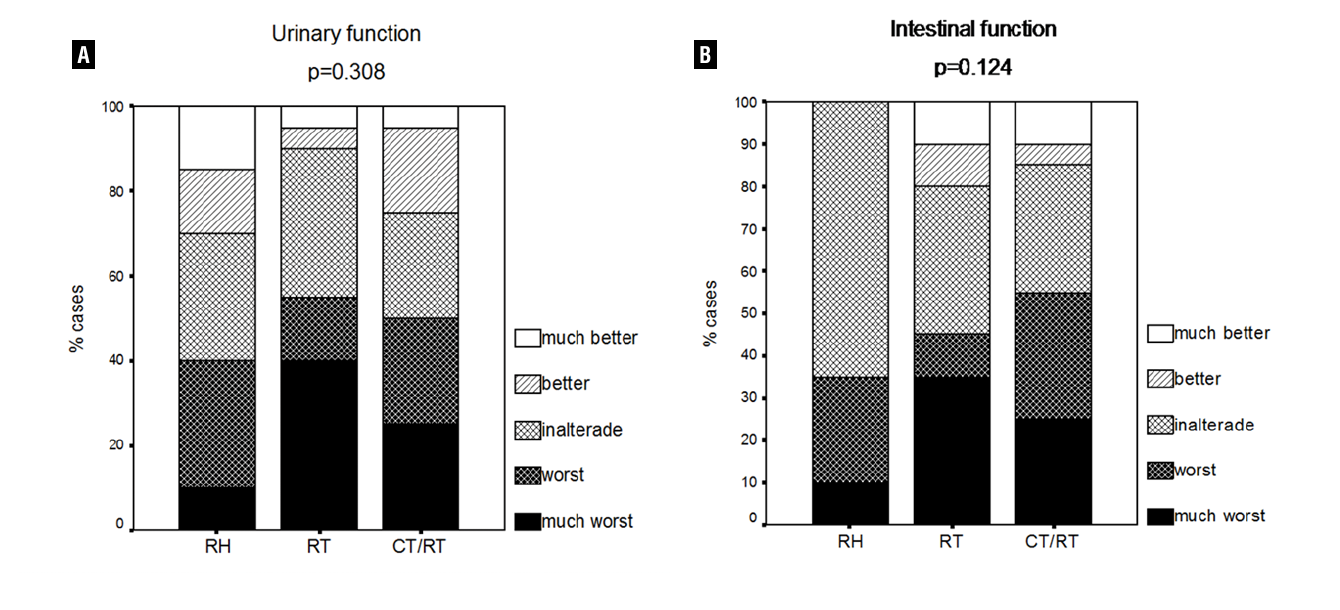
Figure 1 - Distribution of patients subjective perception of urinary (A), intestinal (B) and sexual (C) functions before and after cervical cancer